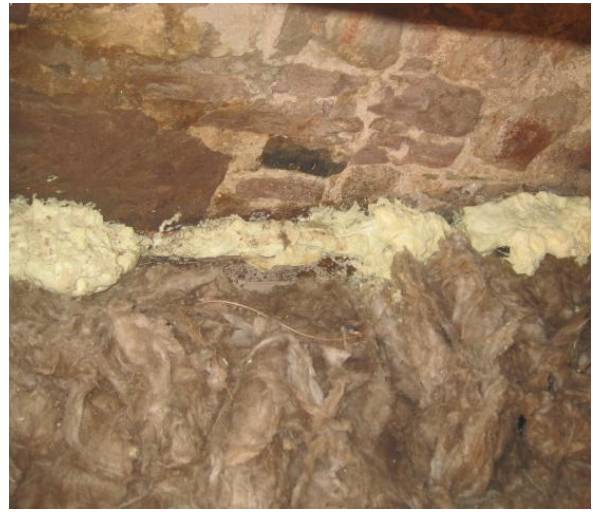
Figure 17. Top of the gable wall, foam seen from the attic